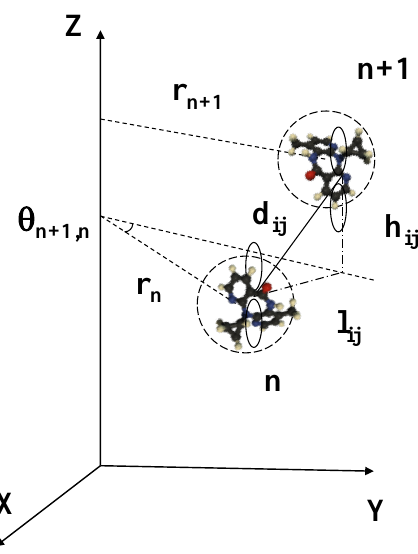
Figure 2. The p z atomic orbitals overlapping between neighboring nucleobases is described in terms of their Euclidean distance d ij , which is determined by the relative twist and radial variables θ n , n + 1 , r n + 1 , and r n . https://link.aps.org/doi/10.1103/PhysRevB.76.245123. Reprinted figure with permission from Maciá, E. Physical Review B, 76, 245123, 2007. Copyright (2007) by the American Physical